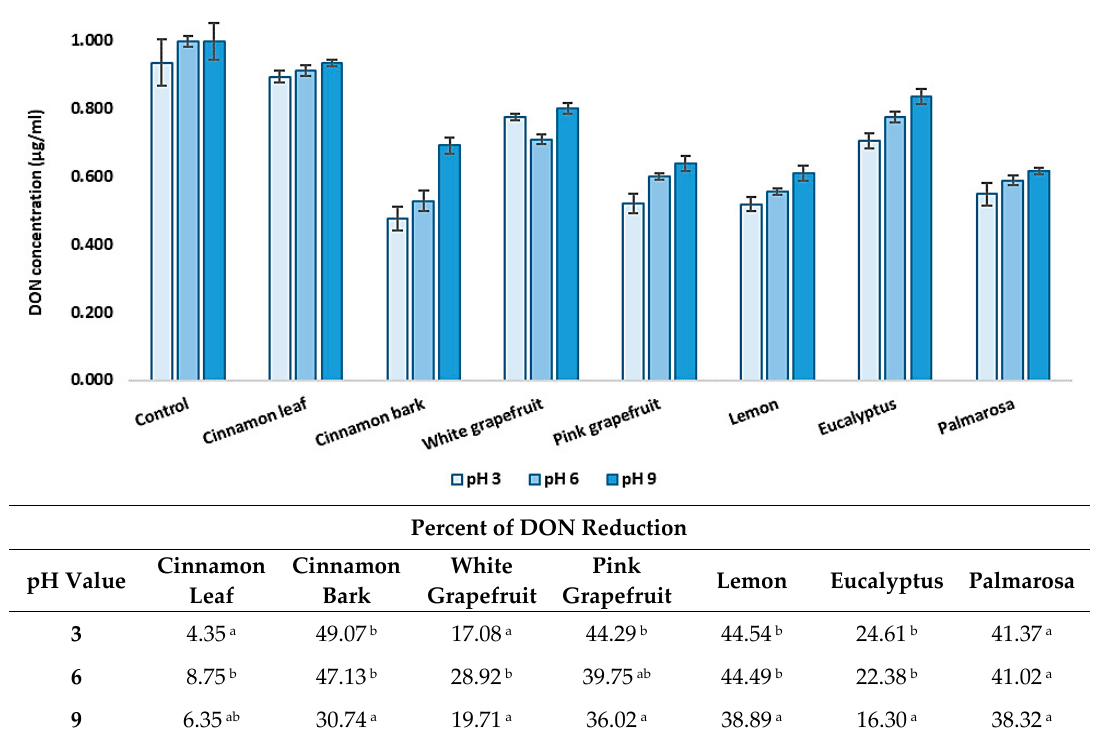
Figure 4. The effect of pH on reduction of deoxynivalenol concentration at 20 °C. The experiment was conducted up to 72 h. Data were analyzed by Tukey’s test at p < 0.05 ( a , b , c — significantly different in column).